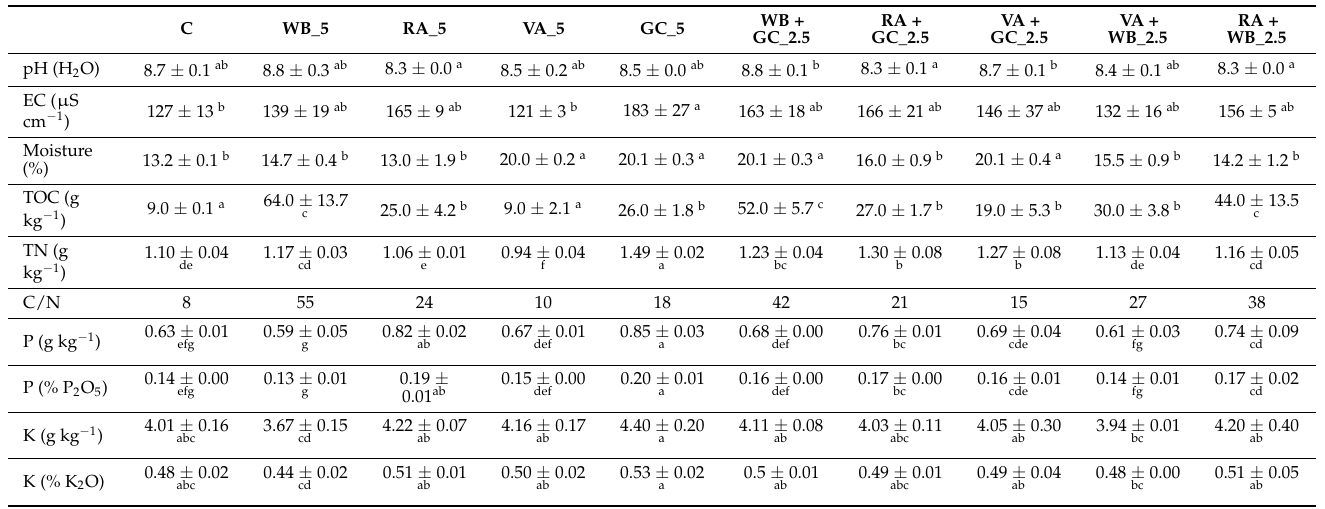
Table 3. Basic properties, elemental composition and macronutrients of soils after the greenhouse experiment (DAS